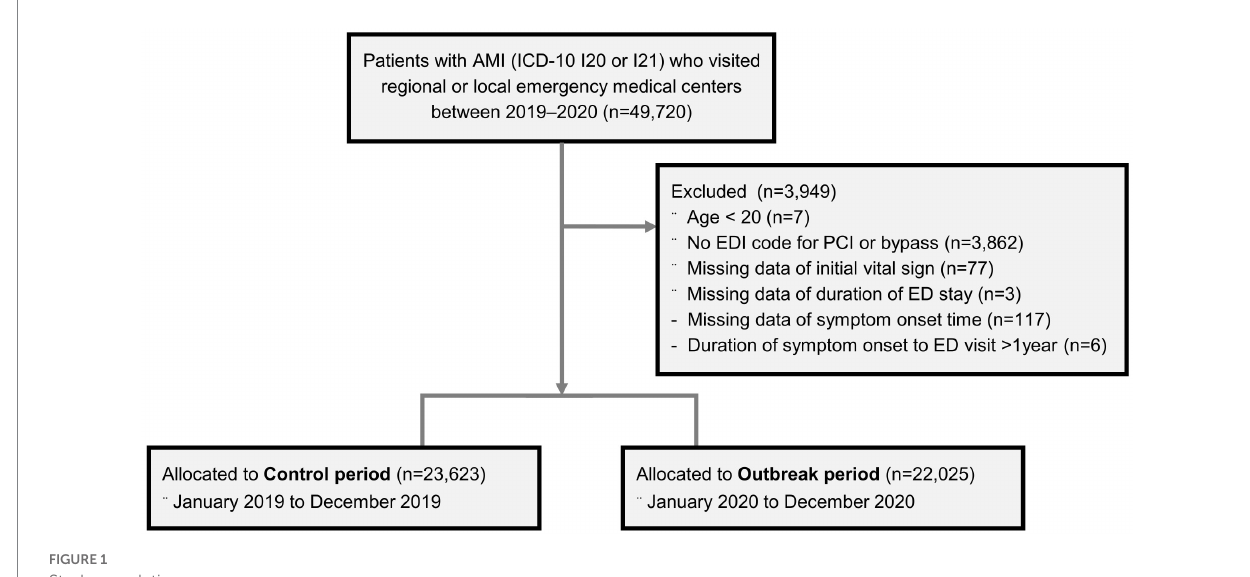
Table 2. Study outcomes were compared between the control and outbreak periods and between patients with and without DM. DM was defined as a primary or secondary diagnosis of ICD-10 codes E10, E11, E12, E13, or E14. In addition, patients with other severe comorbidities such as chronic kidney disease (CKD) stage 4 or 5 (ICD-10 codes N18.4 or N18.5), heart failure (ICD-10 code I50), or old age ( ≥ 80 years) were compared with those without any of the